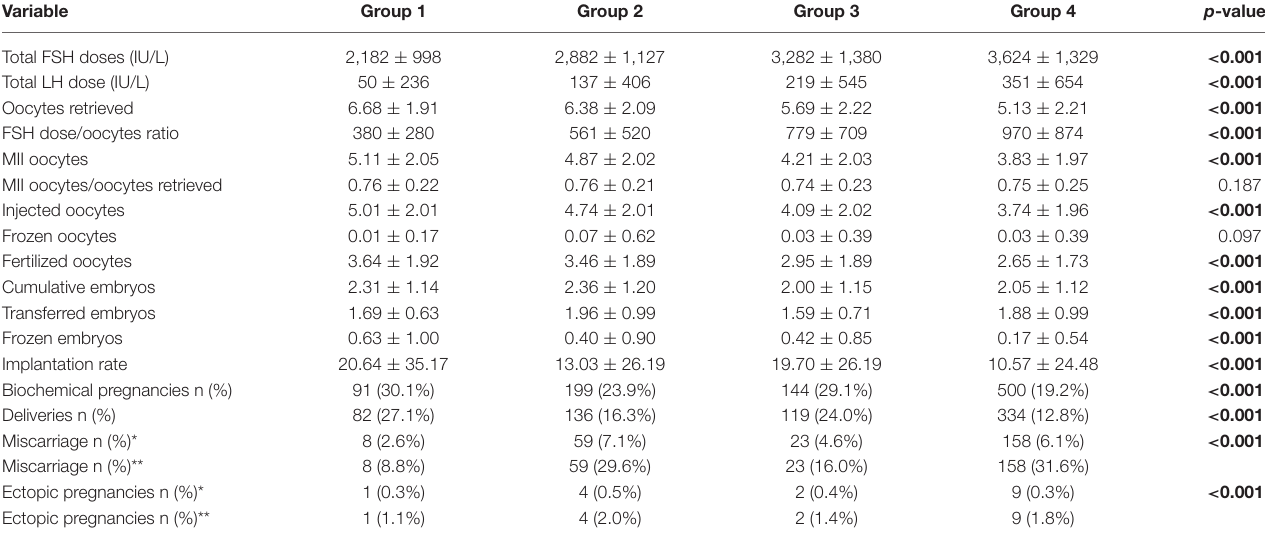
TABLE 4 | ART outcomes women divided according to POSEIDON